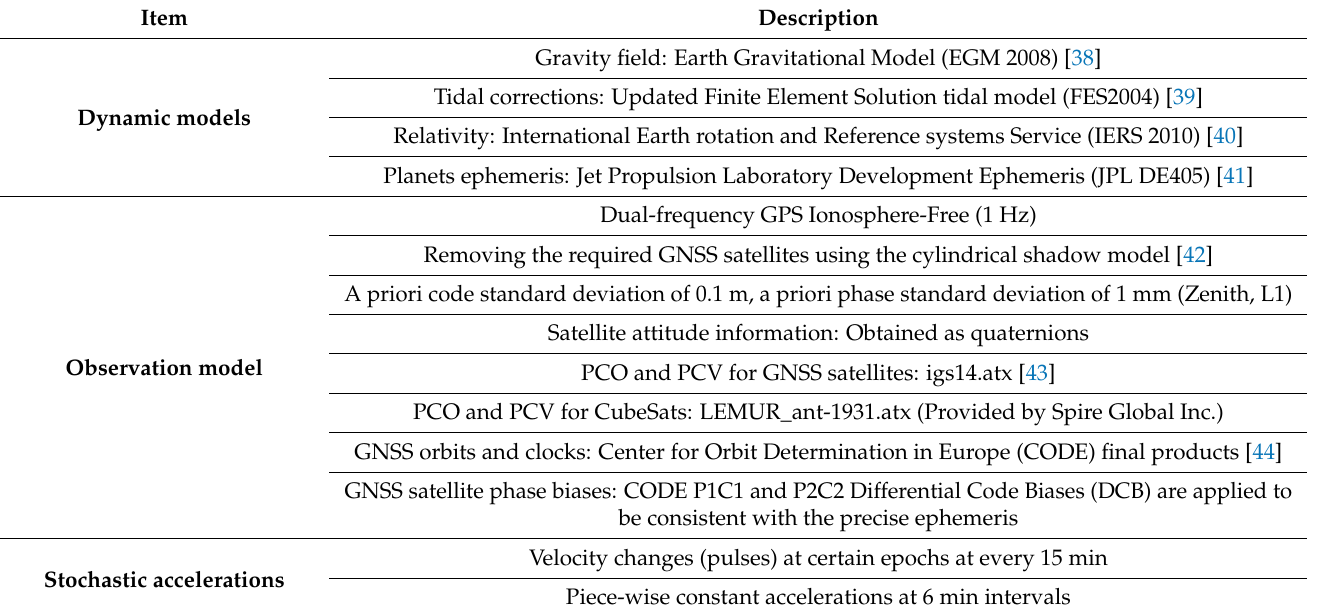
Table 1. POD processing models and